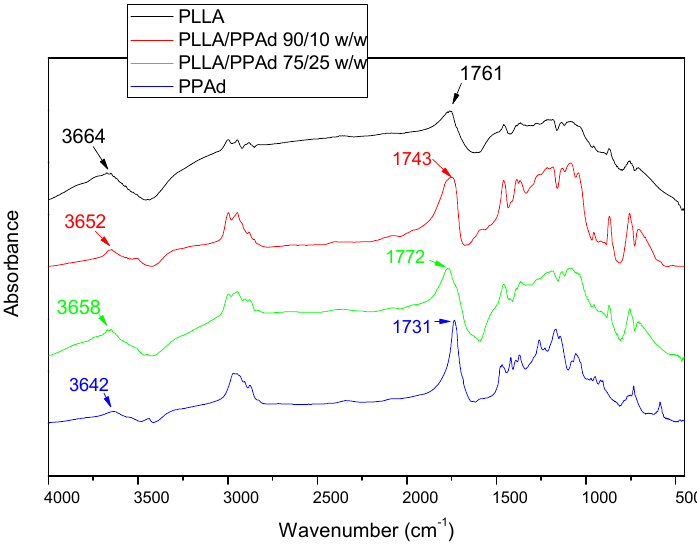
Figure 4. FTIR spectrum of all synthesized polyesters.